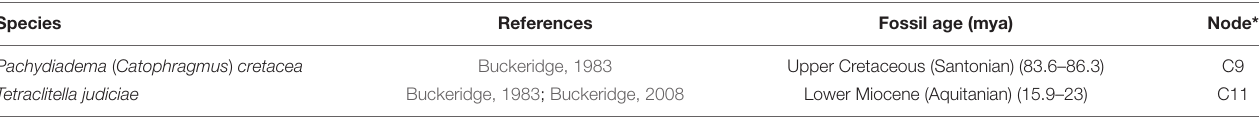
TABLE 2 | Species and ages of fossils used as calibrations for divergence time